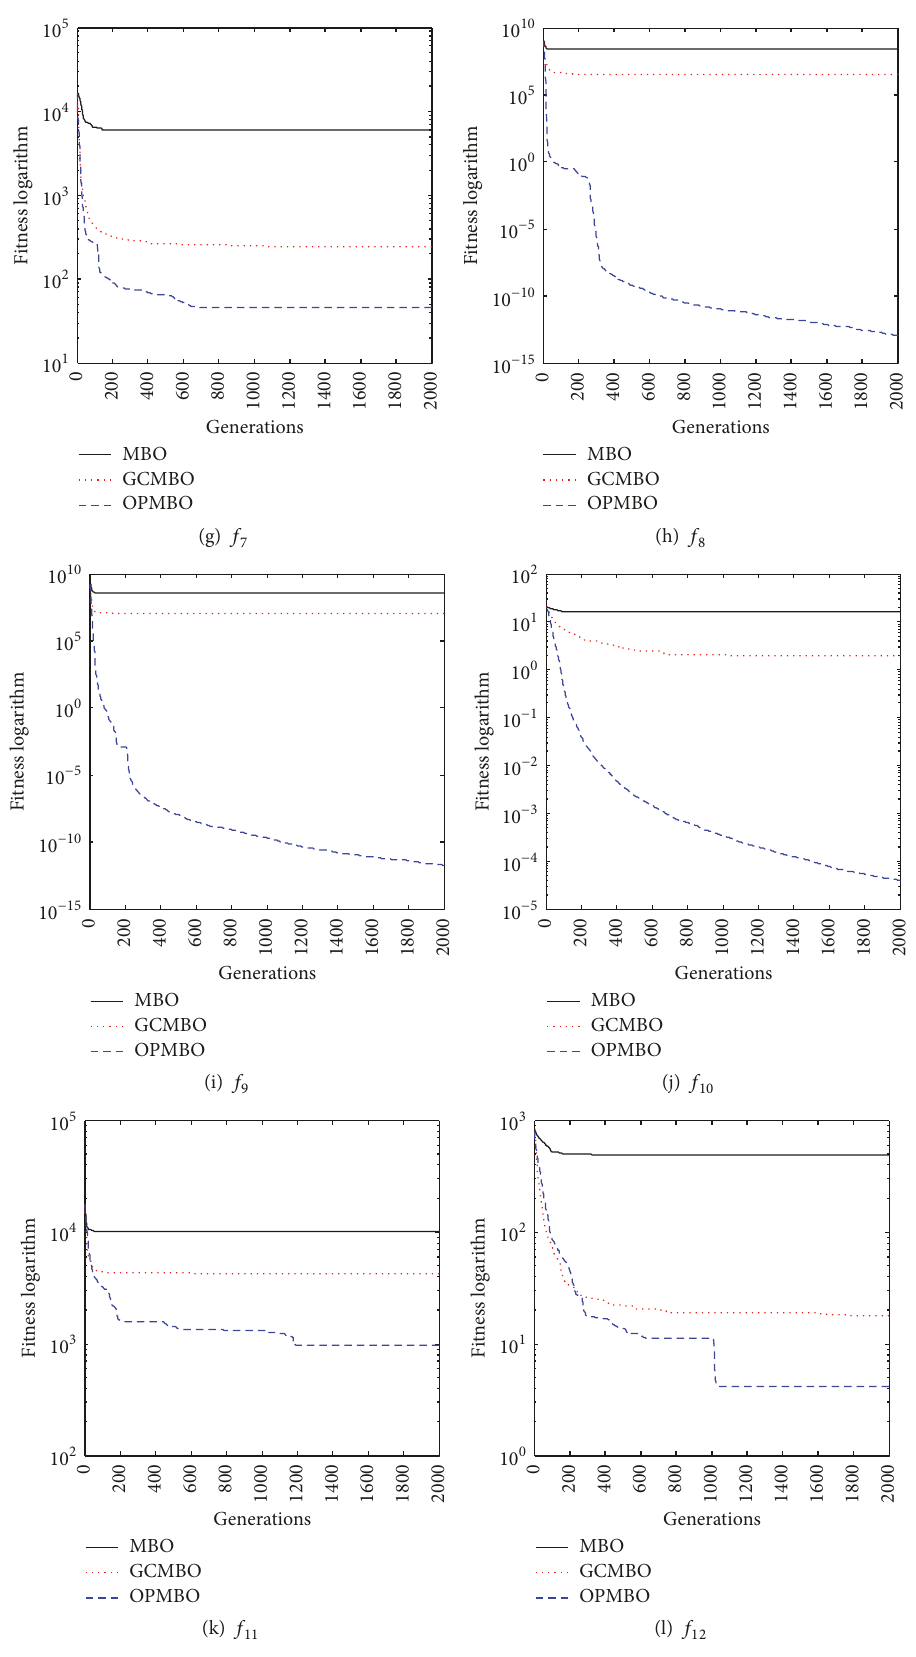
Figure 2: The convergence curves of the three algorithms on the 50-dimensional